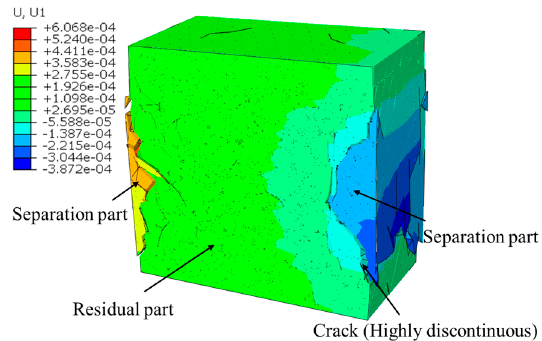
Figure 15. The displacement nephogram whose direction is vertical to the loading one.